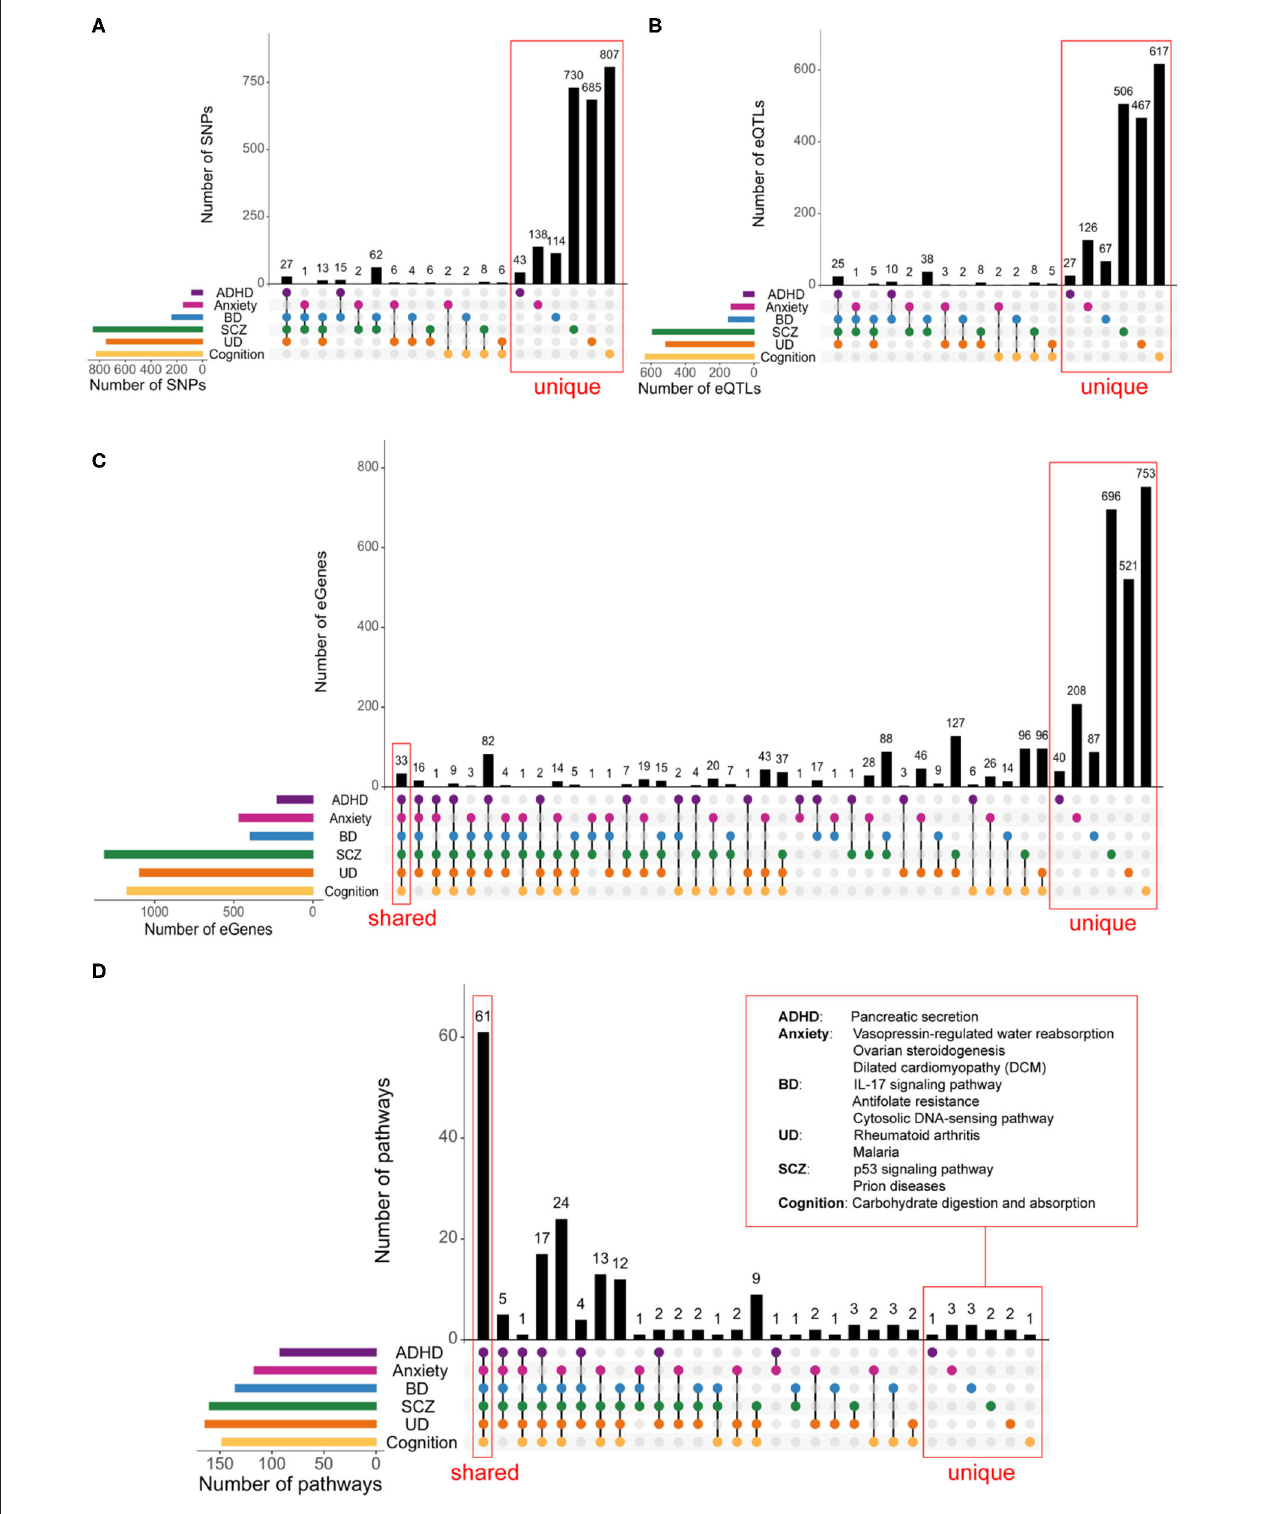
FIGURE 3 | Shared biological pathways link psychiatric disorders and cognition. Psychiatric disorders and cognitive functions have low levels of genetic similarity at the SNPs (A) , eQTLs (B) , and eGene (C) levels. A FDR-adjusted p < 0.05 was used to identify eQTLs and eGenes. (D) Psychiatric disorders and cognition share